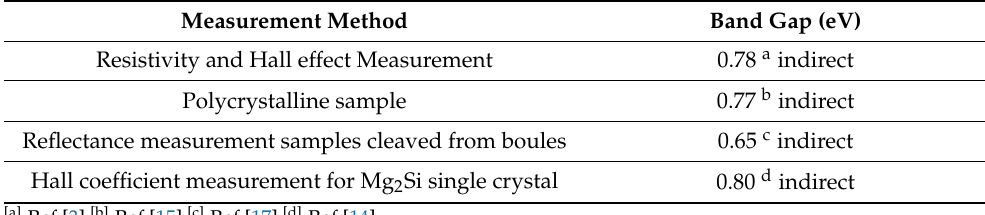
Table 1. Experimental measurements of the band gap of Mg 2 Si.